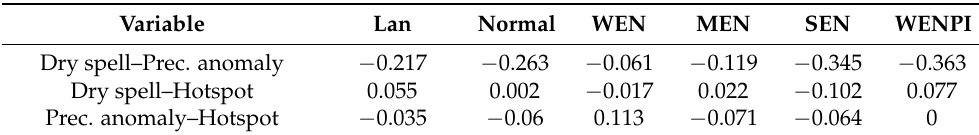
Table 3. Measure of association of each variable pair from 2001 to 2020 of 2nd dry season in northern Sumatra.